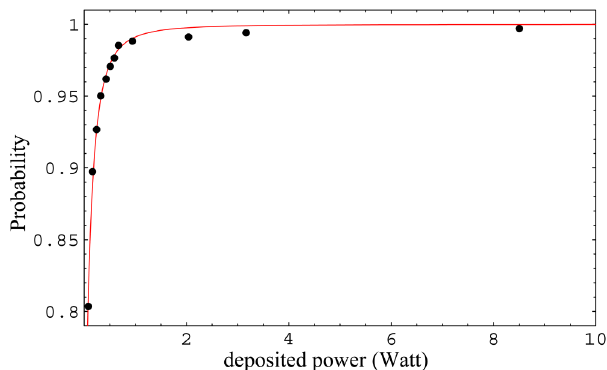
FIG. 24. (Color) GEV fitted with the recorded losses for the most critical cavity. The deposited beam power (W) forms the abscissa and the CDF the ordinate.